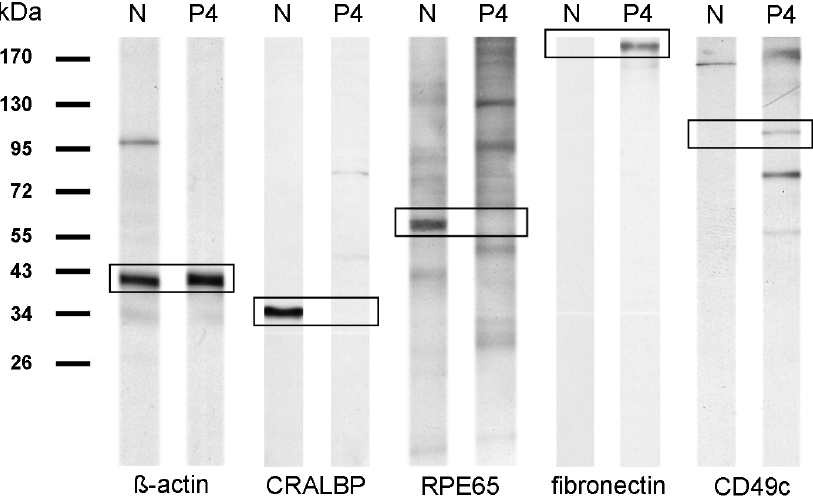
Figure 3. Western blot of a 10% 1D SDS-gel with lysates from native and cultured equine RPE passage-4 cells. N = native; P4 = passage-4. 5 µg protein of each lysate were loaded per lane. Boxes indicate the expected region for a signal regarding the molecular size of the respective protein.